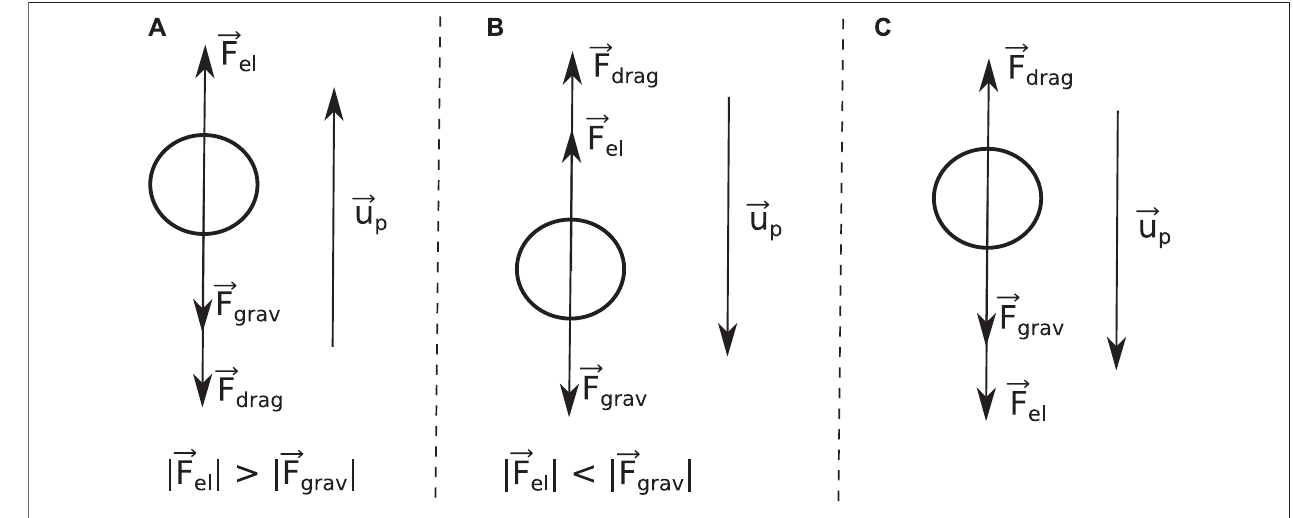
FIGURE 3 | Motion of charged sphere in homogeneous electric and gravitational fi elds: (A) upward motion, (B) and (C) downward motion.